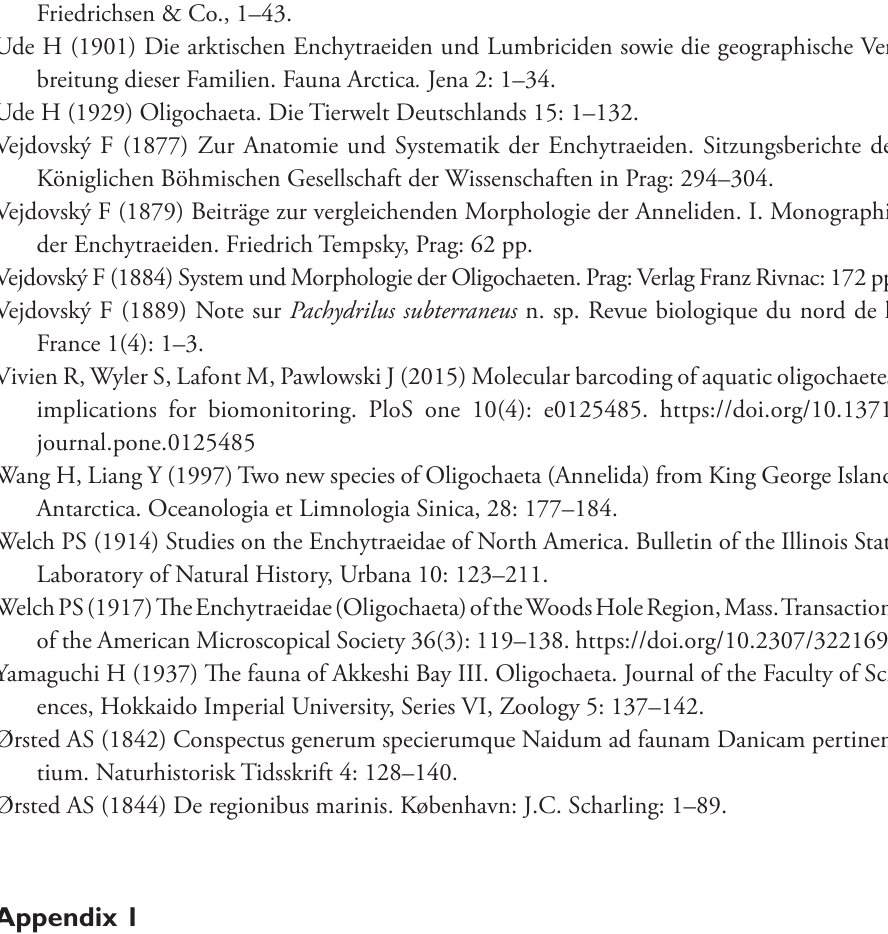
barcode, and voucher numbers. Letters for Lumbricillus pagenstecheri refer to barcod- ing clusters. Country codes: ES=Spain, GL=Greenland, NO=Norway, SE=Sweden and UK=United